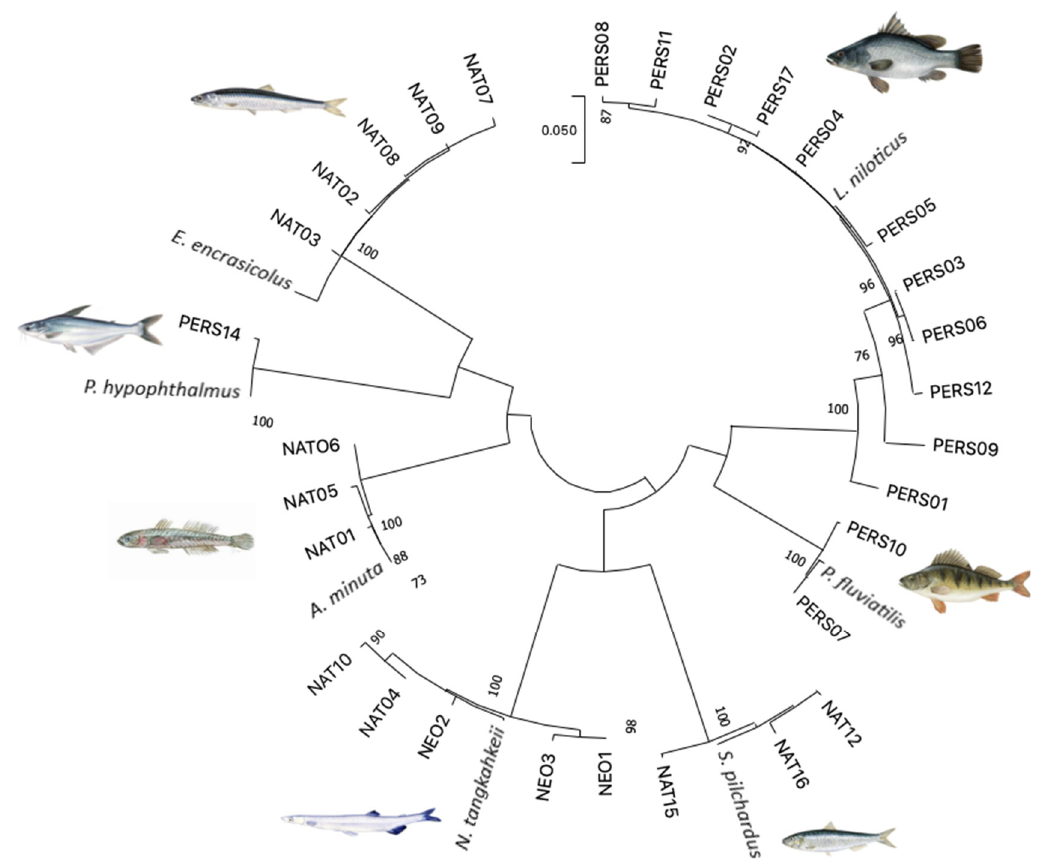
Figure 1. Circular unrooted Neighbour-joining tree (created using MEGA X, [Kumar et al. 2018]) of COI sequences from seafood products examined in this study and reference sequences for each species targeted from GenBank ( A. minuta , KM077808; E. encrasicolus , KU056696; S. pilchardus , MG729586; L. niloticus , MK216590; N. tangkahkeii , OL49421; P. fluviatilis , KT716364; P. hypophthalmus , MH119967). Scale represents numbers of substitutions per site. Numbers at the nodes show bootstrap values greater than